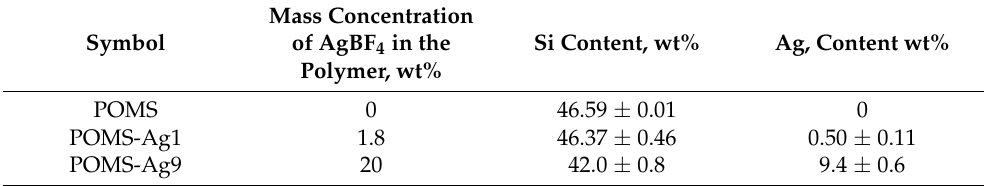
Table 1. Elemental composition of the studied samples of membrane